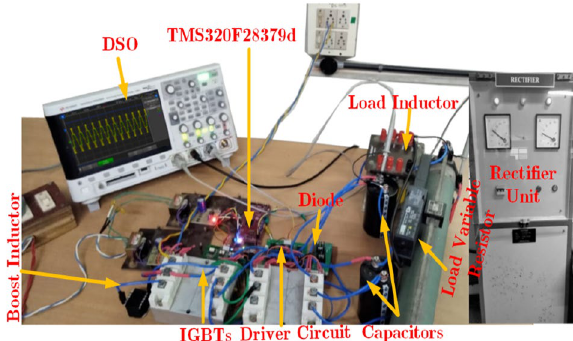
Figure 8. Prototype Hardware Setup.